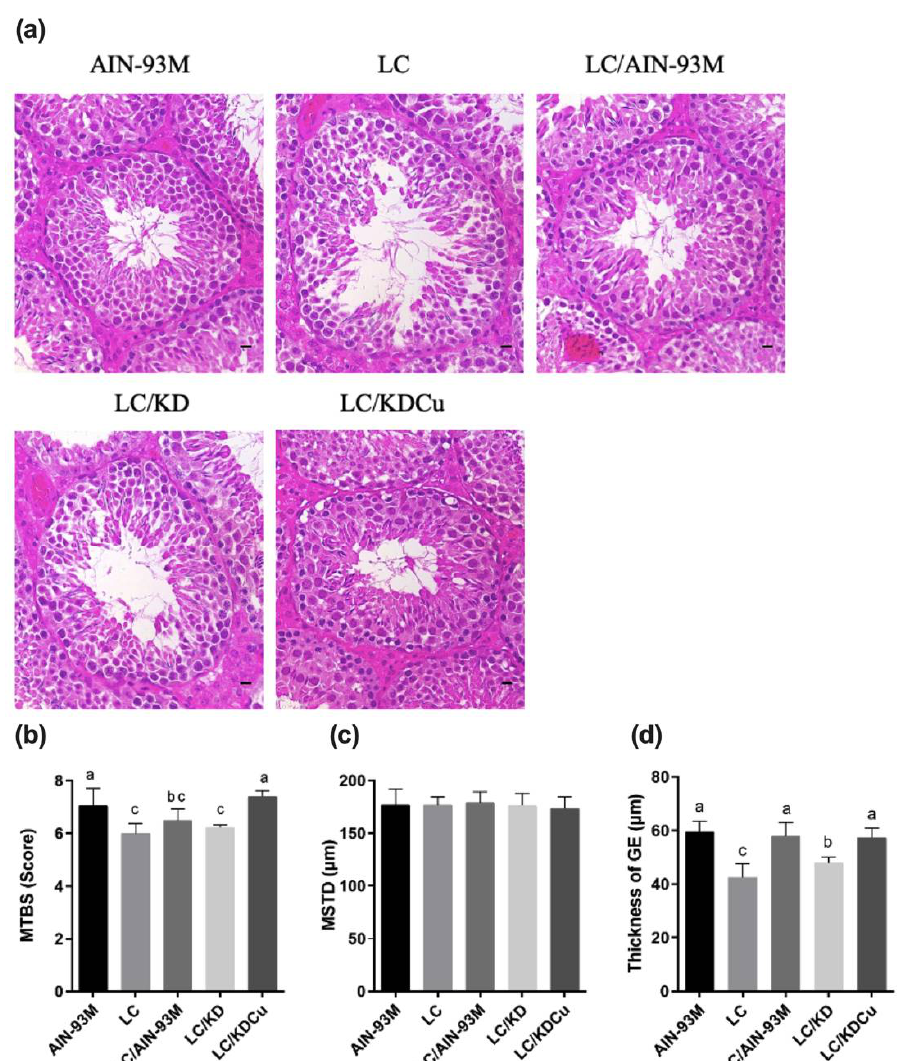
Figure 4. Effects of the low carbohydrate diet and curcumin on ( a ) testicular histology, ( b ) MTBS, ( c ) MSTD, ( d ) thickness of GE in male mice. Data are expressed as means ± SD. n = 5 per group. MTBS: mean testicular biopsy score; MSTD: mean seminiferous tubule diameter. Bars ( a, b, c) with different letters indicate that values are significantly different. (One-way ANOVA, Duncan’s test, p < 0.05). AIN-93M: AIN-93M diet; LC: low carbohydrate diet; LC/AIN-93M: low carbohydrate diet changed to AIN-93M diet; LC/KD: low carbohydrate diet changed to ketogenic diet; LC/KDCu: low carbohydrate diet changed to ketogenic diet and